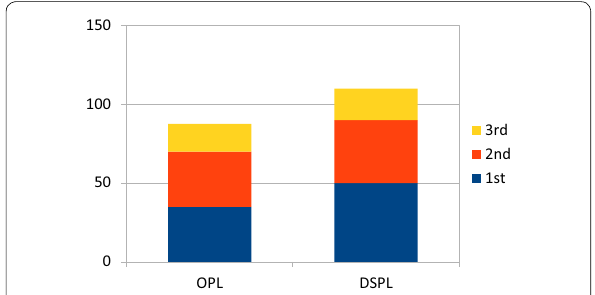
Fig. 29 Total points of top three teams for Storing Groceries in 2018 (Obtained from